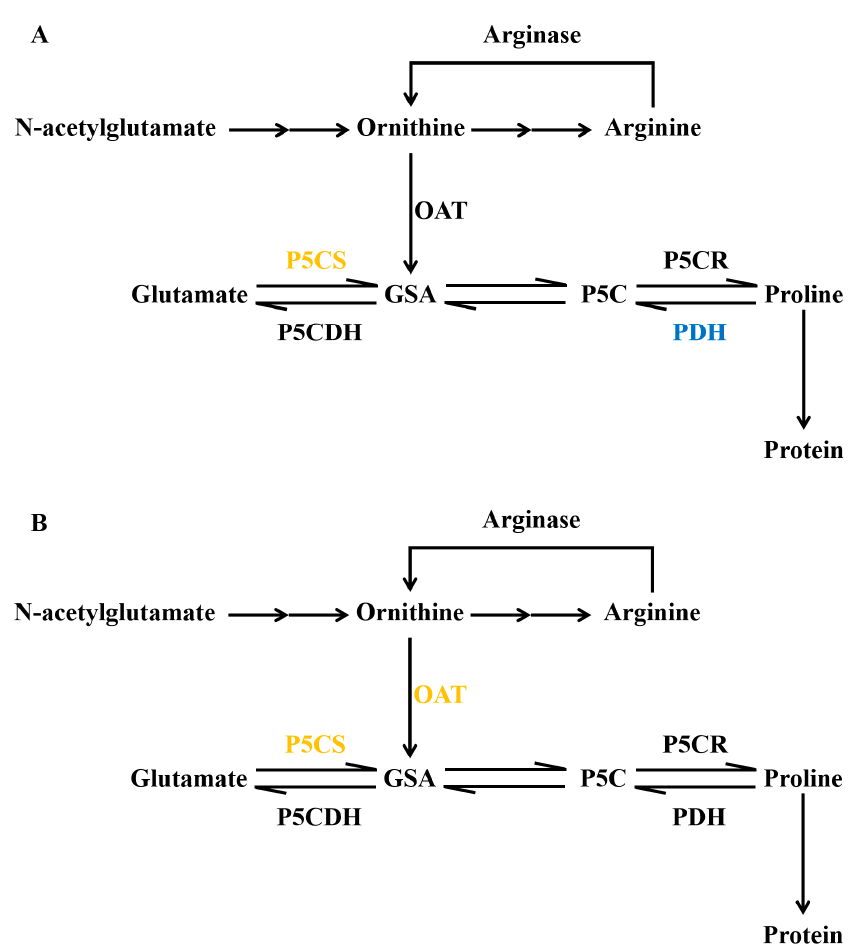
Figure 6. Major DEGs involved in proline metabolism in B. napus . ( A ) Proline metabolism pathway DEGs in CK-R (CK, roots) vs. D-R (drought, roots) and CK-R vs. S-R (salinity, roots). ( B ) Proline metabolism pathway DEGs in CK-L (CK, leaves) vs. D-L (drought, leaves). P5CS ( ∆ 1 -pyrroline-5-carboxylate synthetase), P5CDH (pyrrolidine-5-carboxylic acid dehydrogenase), GSA (glutamate- γ -semialdehyde), P5C (pyrroline-5-carboxylic acid), P5CR ( ∆ 1 -pyrroline-5-carboxylate reductase), PDH (proline dehydrogenase), and OAT (ornithine aminotransferase) function in proline metabolism. Yellow indicates that the underlying DEGs were upregulated, while blue indicates that the underlying DEGs were downregulated.